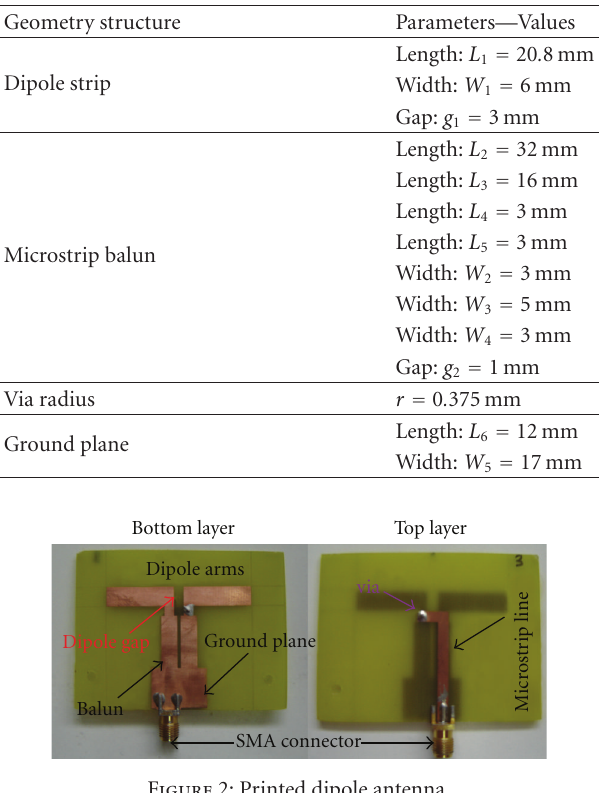
Figure 4: Reflector